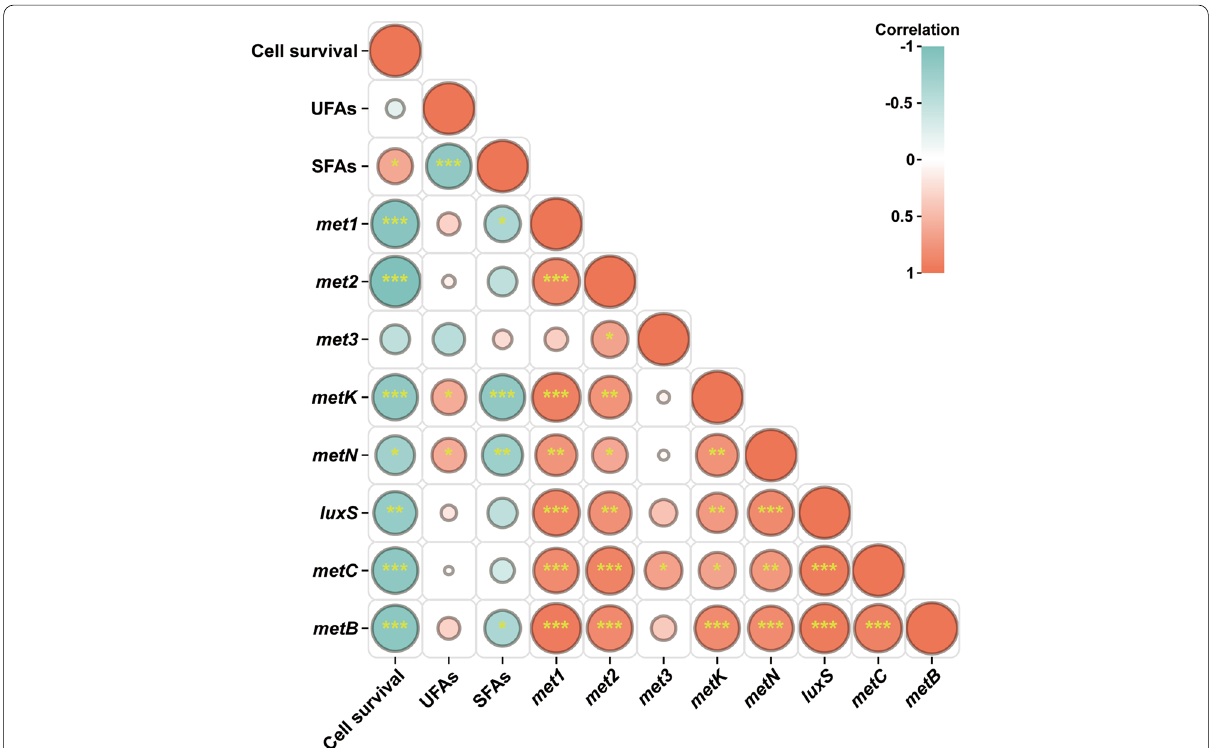
Fig. 5 Correlation analysis of cell viability, membrane lipids and the transcription levels of genes in the methionine metabolic pathway in this study. The mRNA levels of met1 , met2 , met3 were visualized in Fig. S2. * p < 0.05, ** p < 0.01, *** p < 0.001 (Student’s t